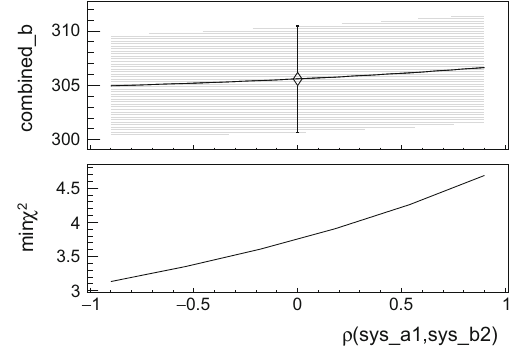
Fig. 15 Combined values for combined_b (upper panel), and min- imum χ 2 (lower panel) for a scan of the correlation coefficient for s- ys_a1 and sys_b2 . The open marker shows the result obtained with the nominal assumption and its uncertainty. The shaded area represents the uncertainty associated to the scanned dependence, indicated by a continuous line. All values are obtained with the example